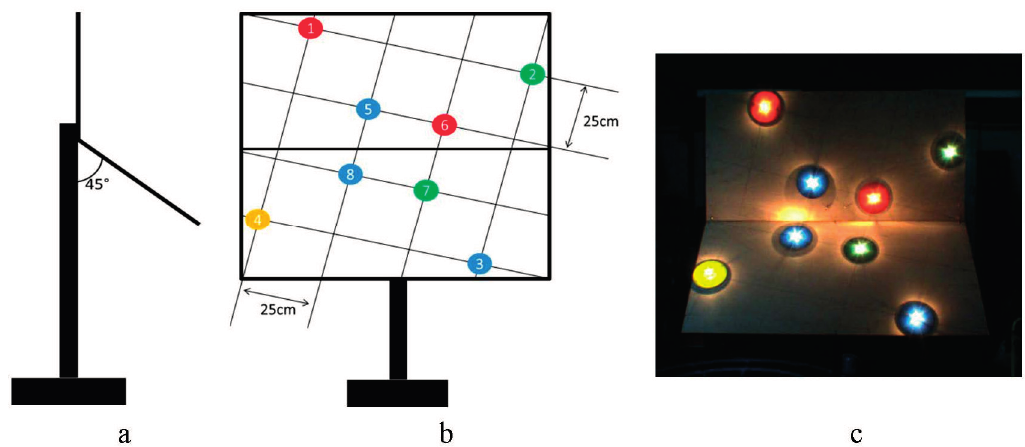
Figure 11. ACPs arrangement. ( a ) side view; ( b ) front view; ( c ) visual image.